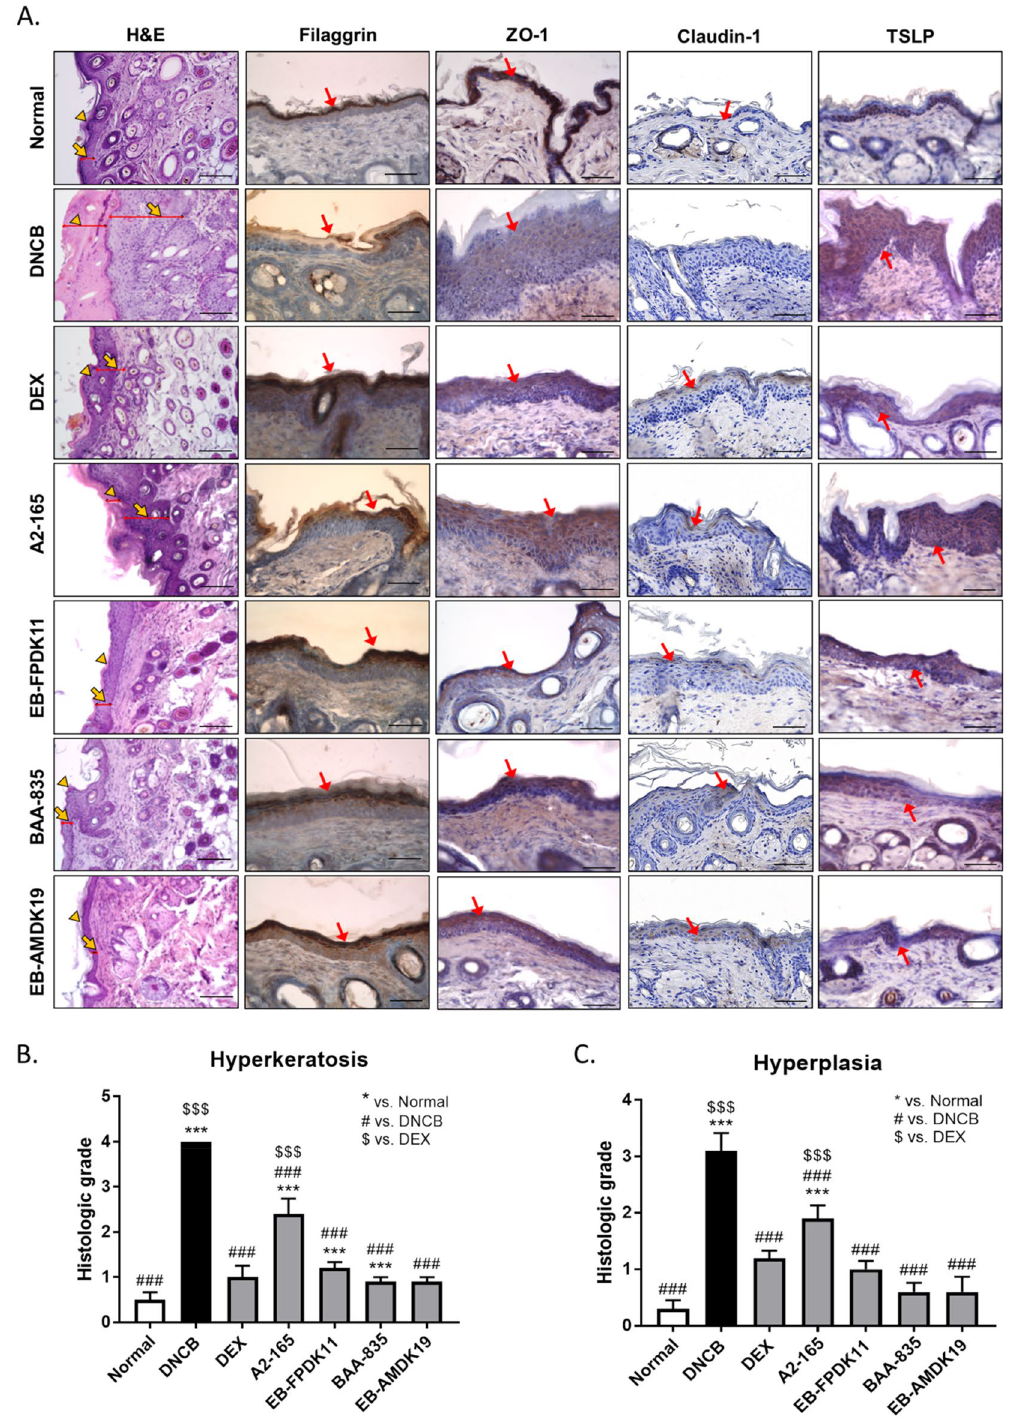
Figure 4. EB-FPDK11 and EB-AMDK19 enhance skin barrier proteins in AD-like lesion in NC/Nga mice. ( A ) The first lane: H&E staining of dorsal skin lesions. The yellow arrowheads indicate hyperplasia, and the yellow arrows indicate hyperkeratosis. The 2nd–4th lane: Immunohistochemical staining of filaggrin, ZO-1, claudin-1, and TSLP, respectively in dorsal skin lesions in DNCB-induced NC/Nga mice. Dark brown regions (the red arrows) indicate positively stained cells. Scale bar, 50 µm. ( B , C ) The graphs represented as ( B ) Hyperkeratosis ( C ) Hyperplasia, histological grades were scored as follows: 0, normal thickness; 1, two times normal thickness; 2, three times normal thickness; 3, four times normal thickness; or 4, greater than four times normal thickness. Data are presented as mean ± SEM of changes in values. * P < 0.05; ** P < 0.01; *** P < 0.001; *versus normal group; # versus DNCB group; $ versus DEX